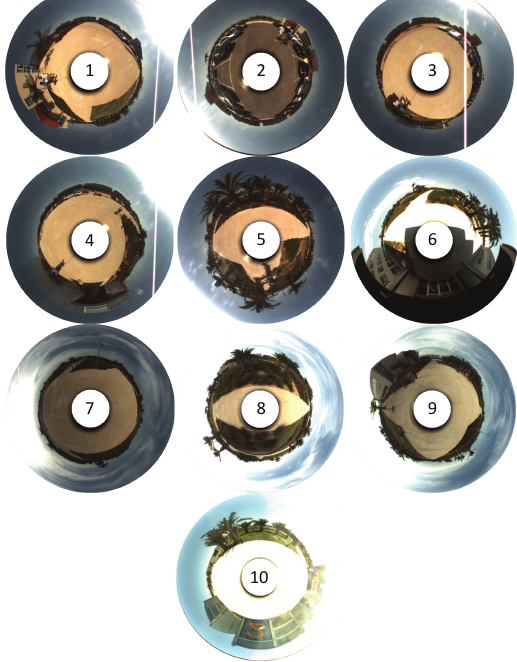
Figure 11. One sample omnidirectional image per outdoor environments is